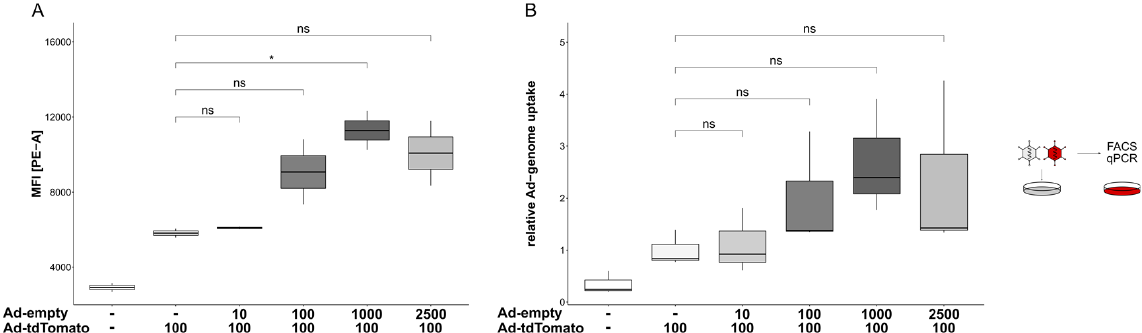
Figure 5. Enhancement effect of pre-treatment did not require a time-shift. Cells were transduced simultaneously with Ad-tdTomato (MOI 100) and escalating doses of Ad-empty. ( A ) Transgene expression at 24 hpt was analysed in flow cytometry. An increased expression could be detected in correlation with increased particle titers of Ad-empty (1.94 ± 0.25-fold, p = 0.021). ( B ) Ad-tdTomato vector genomes were quantified 24 hpt in qPCR. In a similar pattern, although not statistically significant, escalating doses of Ad-empty correlated with an elevated number of Ad-tdTomato vector genomes per cell (2.69 ± 1.1-fold, p = 0.09). Significance values were calculated with Dunnett’s test. MOIs (multiplicity of infection) were applied as indicated. MFI, mean fluorescence intensity; hpt, hours post-transduction; ns, p > 0.05; *, p < 0.05.